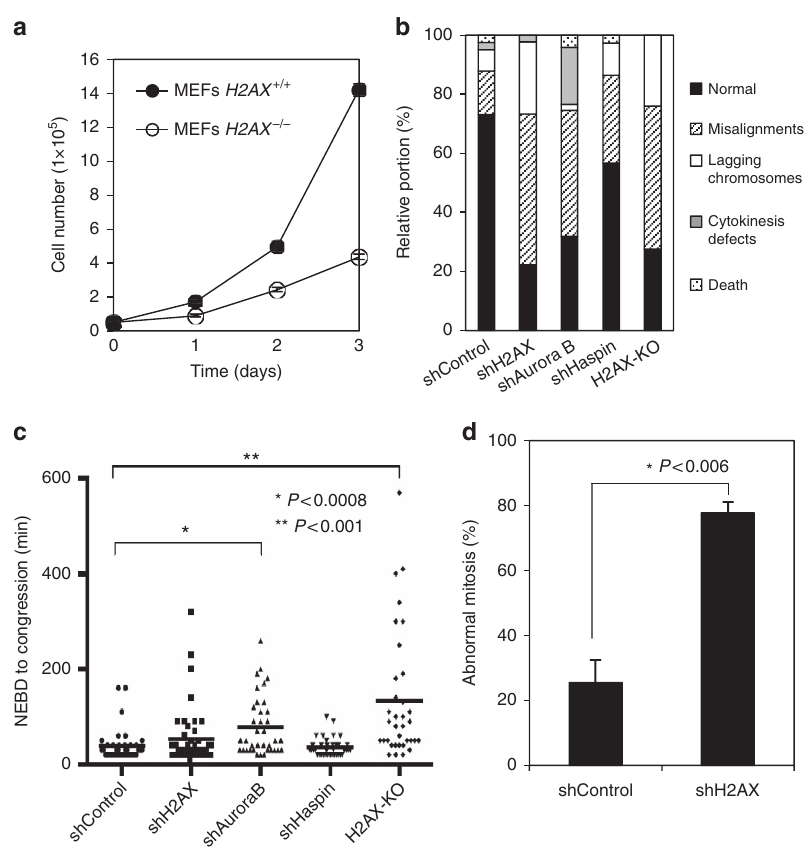
Figure 1 | H2AX is required for proper chromosome segregation. ( a ) H2AX þ / þ and H2AX (cid:2) / (cid:2) MEFs were cultured and their cell numbers were counted at the indicated time points. Data are presented as means ± s.d. of at least three independent experiments. ( b , c ) HeLa cells with H2B-EGFP expressing the Dox-inducible shControl, shH2AX, shAurora B or shHaspin at 24h after the addition of Dox or H2AX-KO HeLa cells with H2B-EGFP were subjected to time-lapse imaging for 24h during cell division to monitor chromosome dynamics. Quantification of cells with the indicated phenotypes is shown ( b ) ( n Z 35). Time interval between nuclear envelope breakdown (NEBD) and congression were measured ( c ) ( n Z 35, Student’s t -test). ( d ) HeLa cells with H2B-EGFP expressing the Dox-inducible shControl or shH2AX were incubated with doxycycline (1 m gml (cid:2) 1 ) for 16h and then synchronized at G2 phase by RO-3306 for 28h. After release from RO, time-lapse imaging was performed for 4h to detect mitotic defects. Percentages of aberrant mitoses are shown as means ± s.d. of at least three independent experiments ( n Z 20, Student’s t